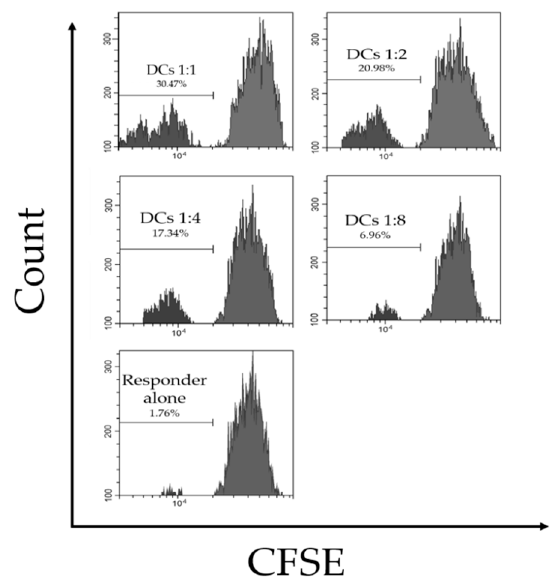
Figure 2. Mixed lymphocyte reaction (MLR) experiments of dendritic cells in grass carp. Grass carp dendritic cells were cultured with 5-(and-6)-carboxyfluorescein diacetate, succinimidyl ester (CFSE) stained spleen responders in a primary allogeneic MLR. The ratios of gDCs to responders were 1:1, 1:2, 1:4, and 1:8. The numbers represent the percentages of dividing responders. Data are representative of four independent experiments, each using stimulators and responders from multiple individual fish.